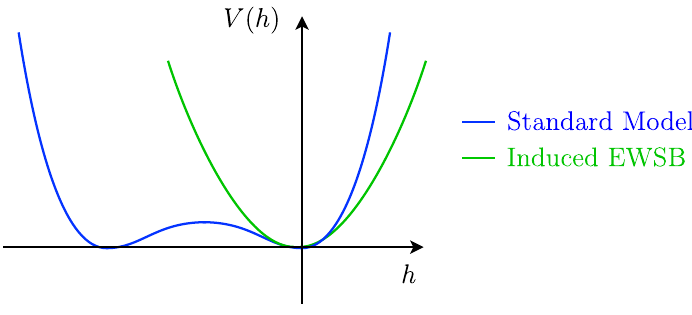
Figure 1 . Higgs potentials in the Standard Model and in induced electroweak symmetry